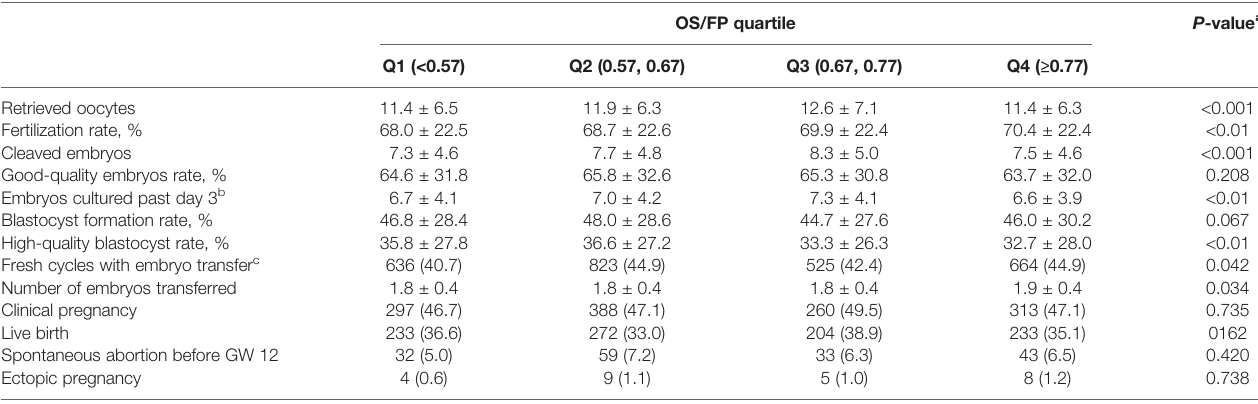
TABLE 2 | Cycle Characteristics of all the participants (N = 6110).